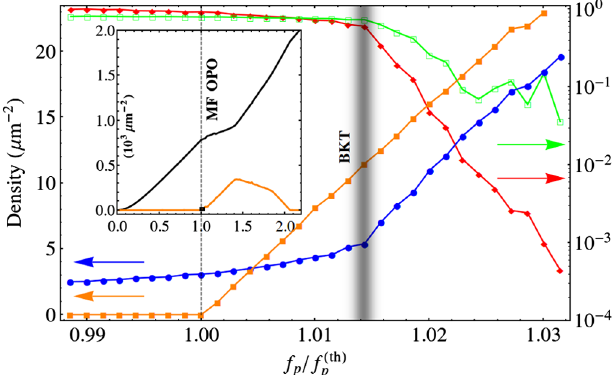
FIG. 3. The phase diagram and the BKT transition. Inset: Mean-field photonic OPO densities for pump n MF (black line) p and signal n MF (orange line) states as a function of increasing s pump power f rescaled by the threshold value f th (vertical black p p ≃ f th dashed line). The black square at f indicates the tiny p p pump strength interval close to mean-field threshold analyzed in the main panel. Main panel: We plot with (orange) squares the same mean-field signal density n MF as in the inset. All other data s are noise-averaged properties from stochastic simulations as a FIG. 2. Binding-unbinding transition and vortex-antivortex function of the pump strength. The noise-averaged signal density proliferation across the OPO threshold. Phase (color map) of n is plotted with (blue) dots, the average vortex number in the s r ; t Þ and position of vortices (black the filtered OPO signal ψ 222 . 8 with signal rescaled by its average maximum value N s ð max ¼ dots) and antivortices (red dots) for increasing values of the (red) diamonds, and the ratio b of noise-averaged and sym- pump power, in a narrow region close to the mean-field OPO metrized distance between nearest-neighboring vortices of oppo- 1 . 00287 f th 1 . 01648 f th threshold f th : (a) f , (b) f , (c) f site charge and of the same charge with (green) empty squares. p p p p ¼ p ¼ p ¼ 1 . 024 36 f th 1 . 017 19 f th , and (d) f . We observe a dramatic The shaded region indicates the pump region for the BKT p ¼ p p transition. Note that the left-hand side axis label applies to data decrease of both the number of V ’ s and AV ’ s, as well as the marked by orange squares and blue dots, while the right-hand typical distance between Vand AV within a pair, as a function of side axis label applies to data marked by red diamonds and green the increasing pump power. The filtered profiles are plotted at a empty late stage of the dynamics, at which a steady state is reached.